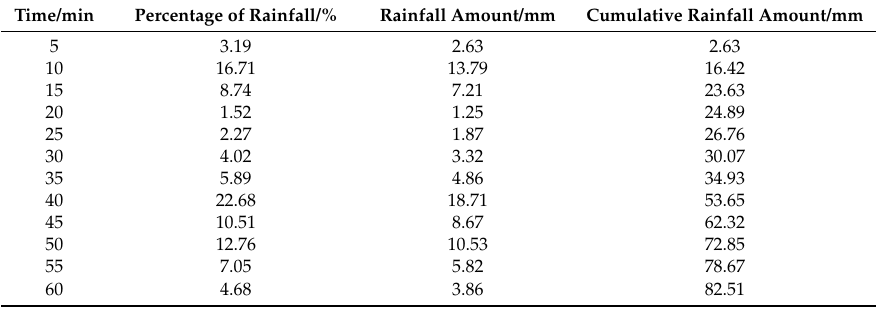
Table 4. Rainfall allocation of double-peak rainstorm with a 60-min duration and a 20-year return period in Yangpu